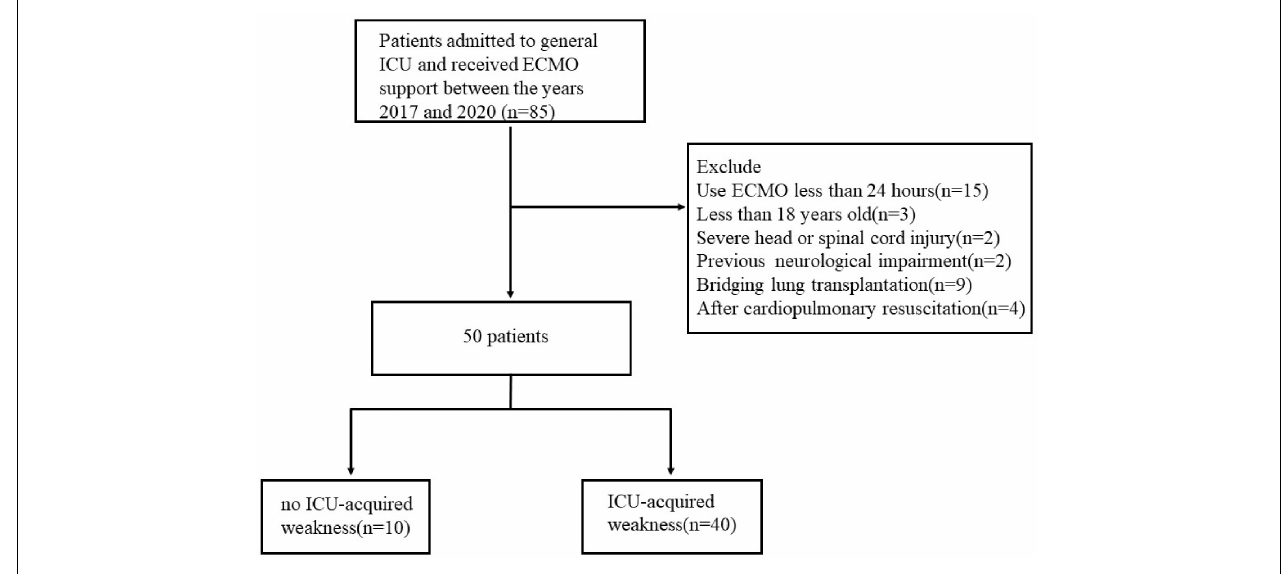
FIGURE 1 | Flow diagram of patients in study.